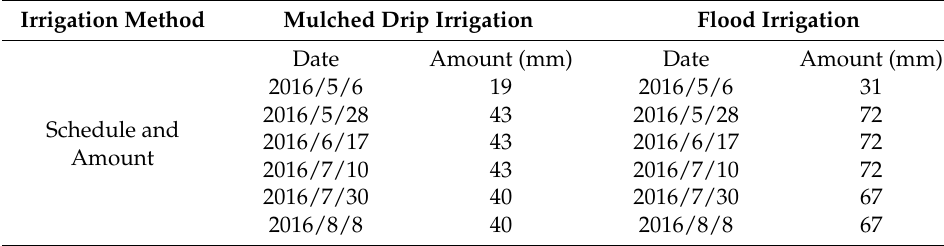
Table 2. Schedule of irrigation events and amounts under mulched drip irrigation and flood irrigation.